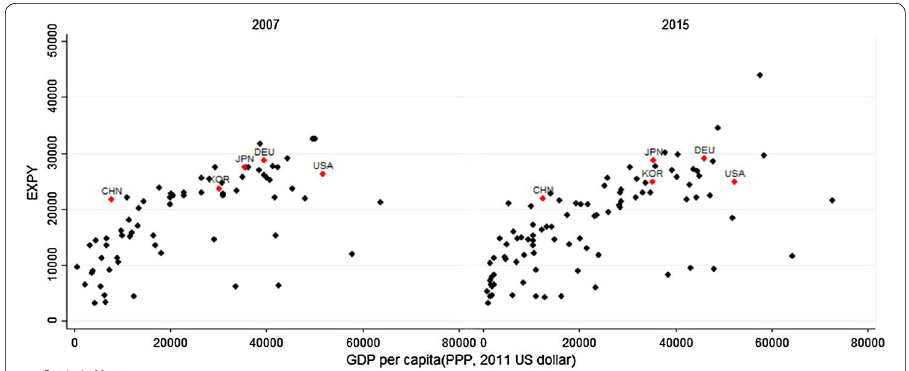
point out a systematic difference in coefficients in all the regressions. Ratio enters with a positive coefficient that is statistically significant in all FE specifications. The estimated coefficient is distributed between 0.034 and 0.054. This result implies that there is a posi- ing